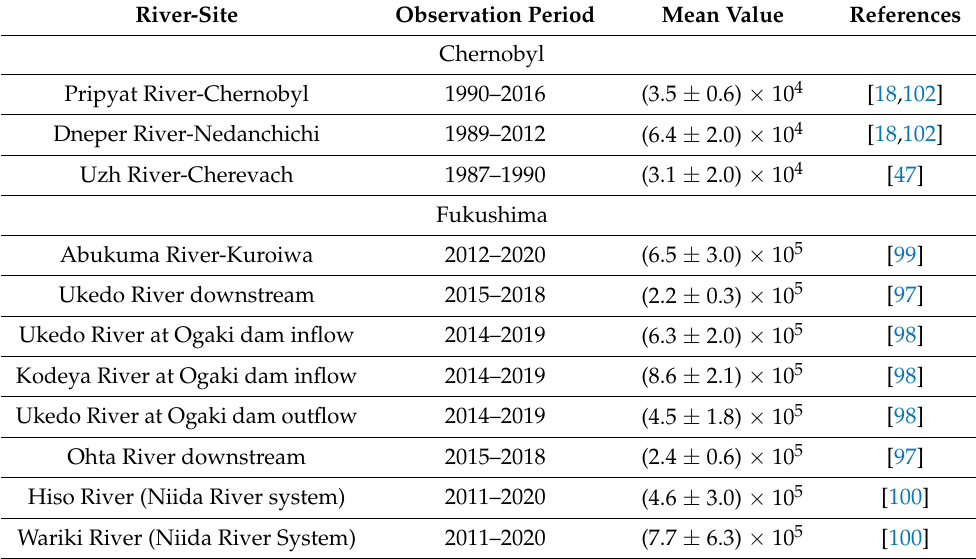
Table 1. 137 Cs apparent distribution coefficient K d (L/kg) in suspended sediment–water system of rivers in Chernobyl- and Fukushima-contaminated